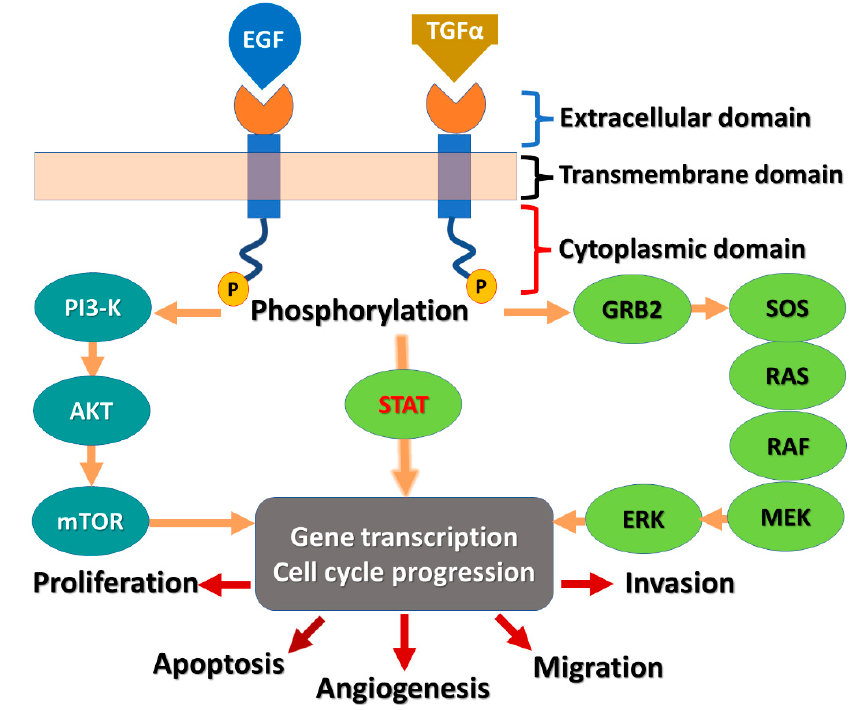
Figure 1. Diagram of the EGFR receptor and the signaling cascade: AKT, protein kinase B; EGF, epidermal growth factor; EGFR, EGF receptor; ERK, extracellular signal-related kinase; GRB2, growth factor receptor-bound protein-2; MEK, mitogen-activated protein kinase-ERK kinase; mTOR, mammalian target of rapamycin; P13K, phosphatidylinositol 3-kinase; SOS, son of sevenless; STATs, signal transducers and activators of transcription; TGF- α , tumor growth factor- α .